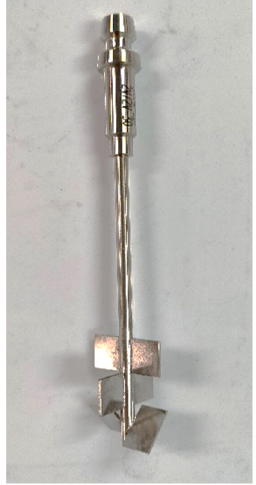
Figure 1. The paddle-type stirring rotor.